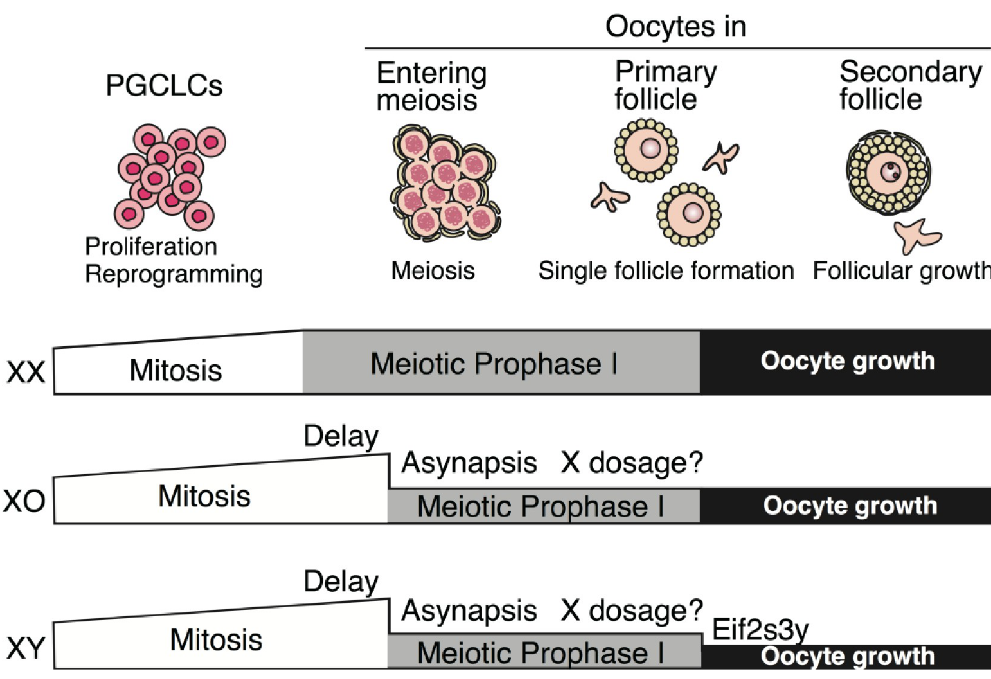
Fig 6. Summary of oogenesis in culture using XX, XO and XY ESCs. Differentiation of XO and XY oocytes is disrupted at three points. First, meiotic initiation was delayed in XO and XY oocytes. Second, pairing of homologous chromosomes was severely disrupted in XO and XY in oocytes. Although X-transcripts in XO and XY oocytes were lower than those in XX, how it affects to loss of oocytes is not clear. Third, Eif3s3y has a negative impact on oogenesis, although the molecular function remains to be